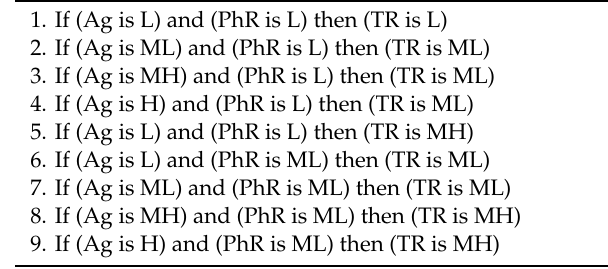
Table 5. Rules defined for the FIS sub-model used to estimate Total Risk levels. TR = Total Risk, PHR = Physical Risk, AG = Aggravation, VH = very-high; H = high; MH = medium-high; ML = medium-low; L =